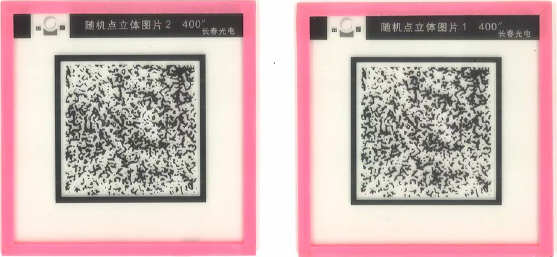
Figure 2. A pair of synoptophore slides with random-dots